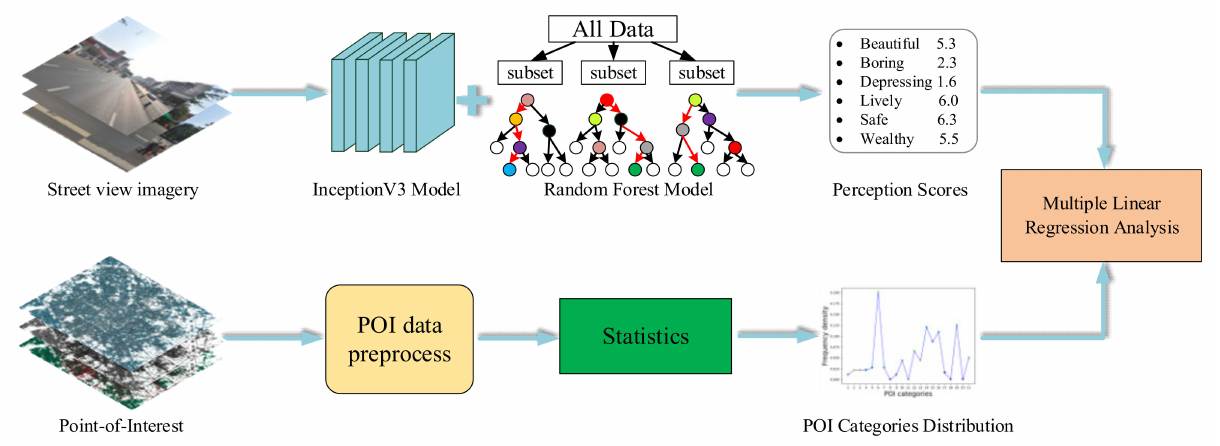
Figure 5. Multiple linear regression analysis between the perceptual scores and the POI